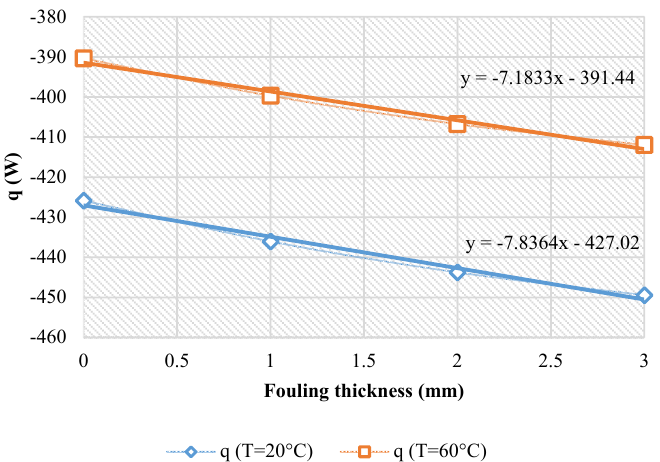
Figure 8. Heat transferred in function of the fouling thickness for both water-tube temperatures (20 °C and 60